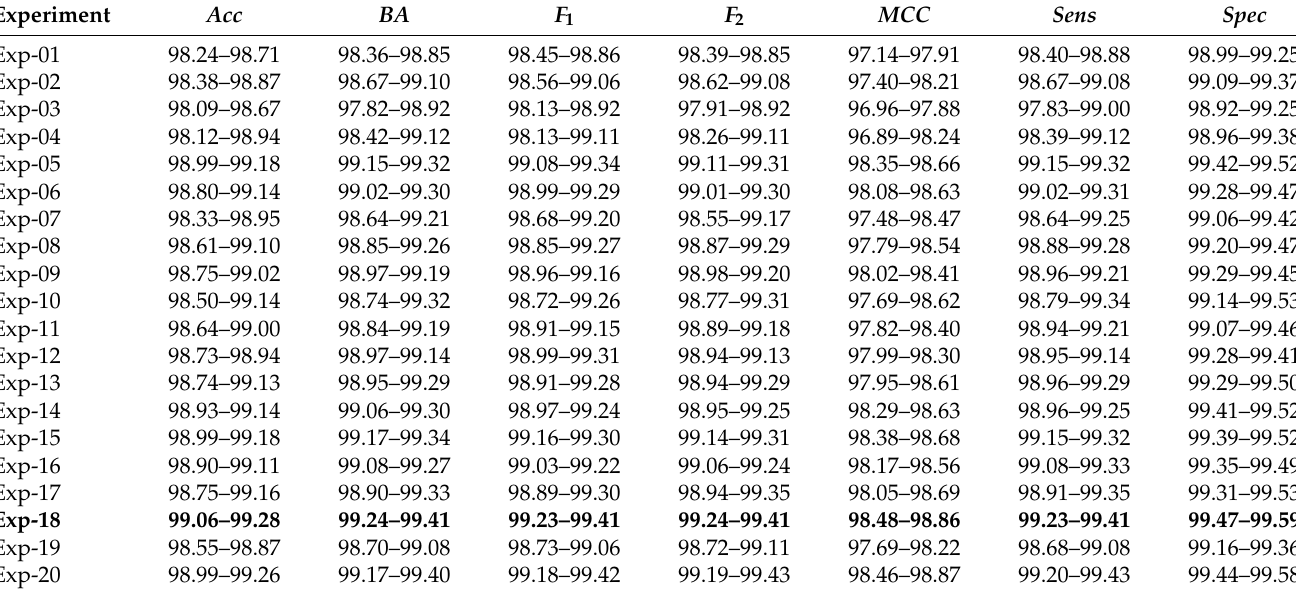
Table 11. Confidence interval by experiment for Acc , BA , F 1 , F 2 , MCC , Sens and Spec after 1000 bootstrapping cycles with α = 0.05. Best results are highlighted in bold. Experiment 18 corresponds to ResNet-50r with AdamW and